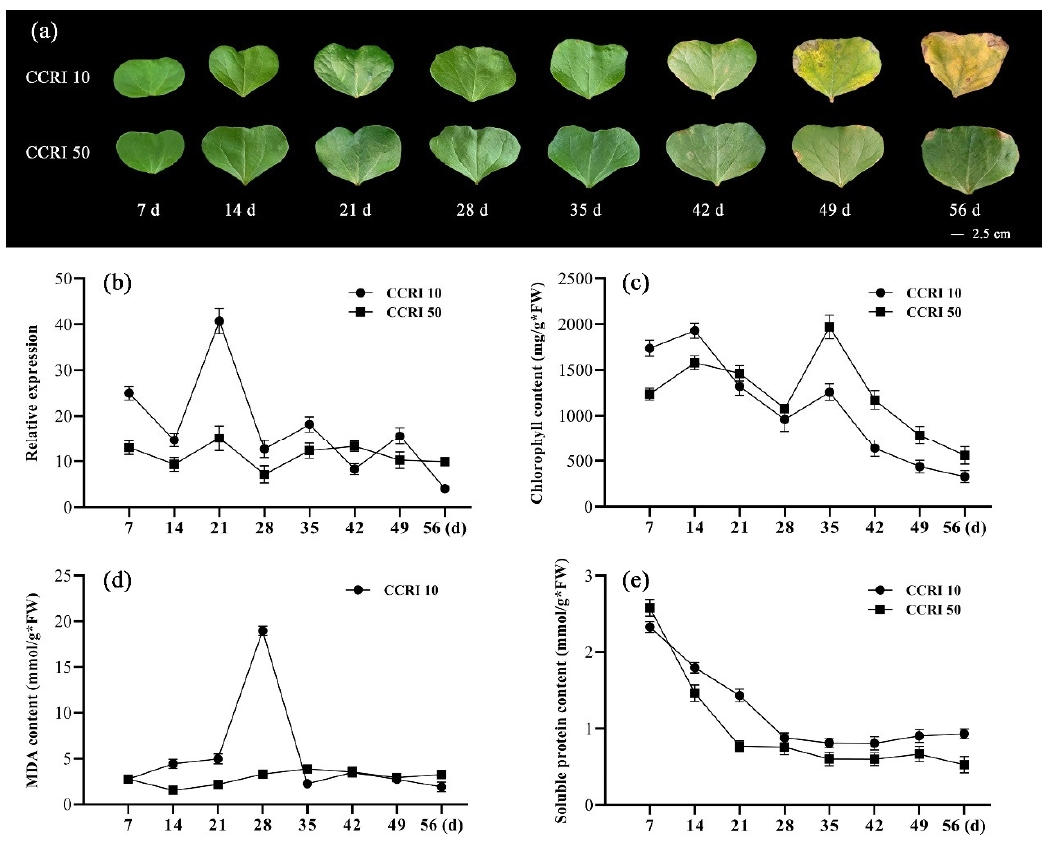
Figure 4. Expression profiles and physiological indexes in 7-, 14-, 21-, 28-, 35-, 42-, 49-, and 56-day- old of the CCRI 10 and CCRI 50 cotton variety during cotyledon senescence. ( a ) Colors change of cotyledon during developmental stages; ( b ) The expression pattern of GhNAC82 during cotyledon development, and GhUBQ7 was used as reference gene; ( c – e ) The content of chlorophyll, MDA, and soluble protein among different developmental stages, n ≥ 3.